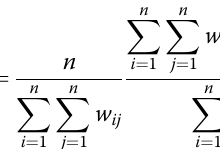
Fig. 1 Distribution of Thai SMEs according to